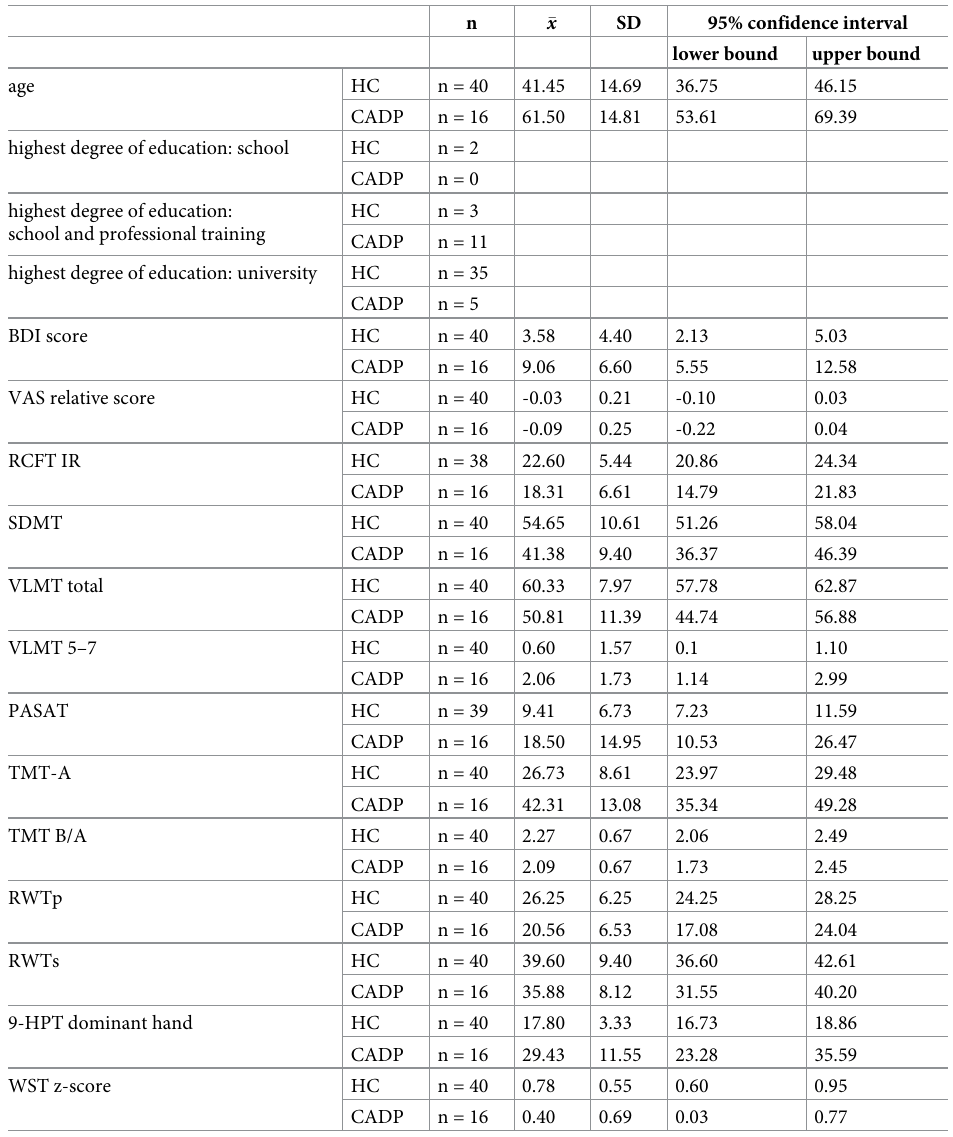
Table 2. Descriptive statistics of the chronic autoimmune demyelinating polyneuropathy (CADP) patients and healthy controls (HC). � x = mean; SD = standard deviation; BDI-score = Beck Depression Inventar score; VAS relative score = relative score in Visual Analogue Scale; RCFT IR = Immediate Recall trial in the Rey Complex Figure Test; SDMT = Symbol Digit Modalities Test; VLMT total = total number of correctly recalled items in trials 1 to 5 of the Ver- baler Lern- und Merkfa¨higkeitstest; VLMT 5–7 = “trial 7”–“trial 5” difference in the VLMT; PASAT = Paced Auditory Serial Addition Test; TMT = Trail Making Test; RWT p/s = phonemic/semantic subtests of the Regensburger Wort- flu¨ssigkeits-Test; 9-HPT = 9-hole peg test; WST-z-score = Wortschatztest